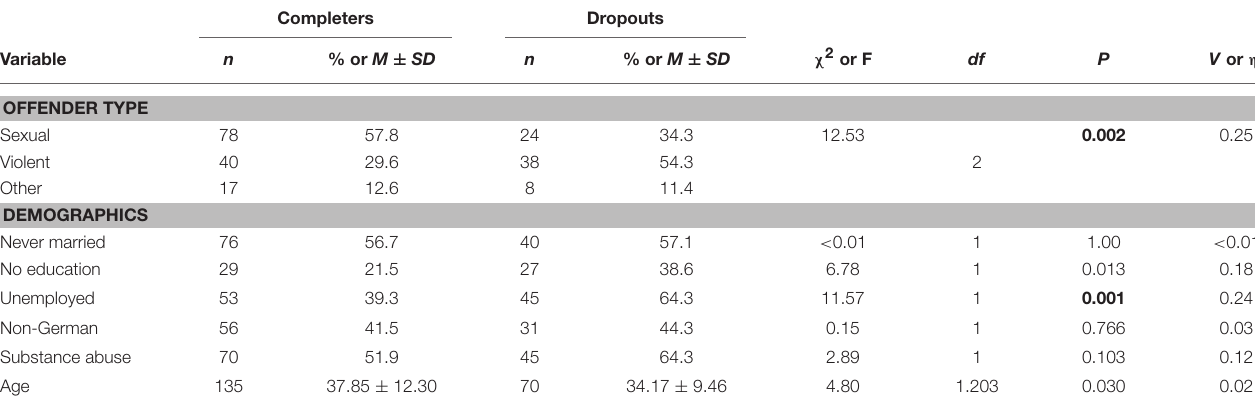
TABLE 2 | Comparisons of completers ( n = 135) and dropouts ( n = 70) regarding offender type and various demographics. Completers